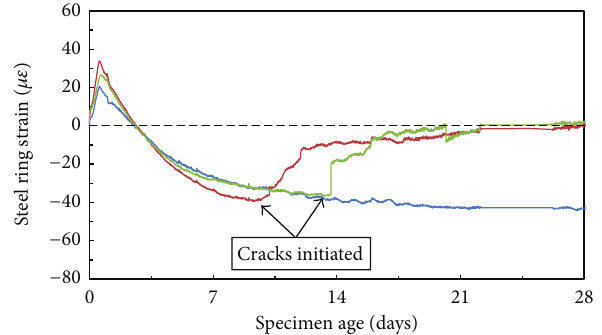
Figure 3: Restrained ring strain development over time for Mixture number 1. Each line denotes the average of four (4) strain readings for one ring. Three (3) rings were tested.